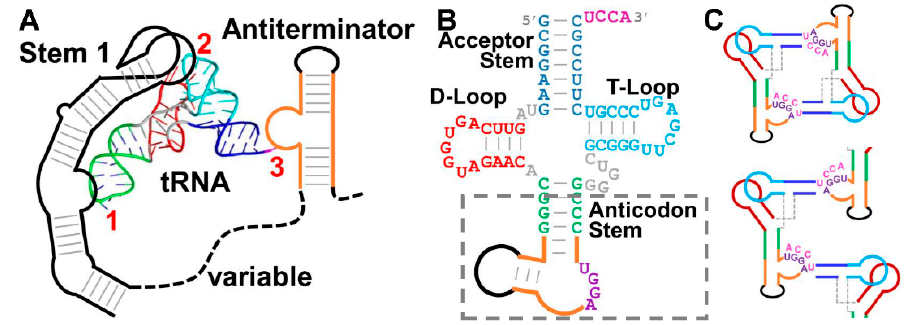
Figure 1. Engineering tRNA fusions. ( A ) Schematic of the T-box riboswitch–tRNA complex with the three previously demonstrated intermolecular contacts highlighted by red numbers. The conserved T-box structure is shown schematically with stems indicated by grey base pairs and loops and bulges shown unpaired. The antiterminator portion of the T-box RNA that is the focus of this work is highlighted in orange. The more variable region of the T-box structure is indicated by a dashed line. tRNA is shown as a cartoon with the acceptor stem in blue, the D-loop in red, the anticodon stem loop in green, the T-loop in cyan and the 3 ′ acceptor extension in magenta. ( B ) Secondary structure model of the G. kaustophilus tRNA Gly scaffold used in this work, colored as in Panel A, with antiterminator stem-loop insertions (highlighted by a dashed grey box) in the anticodon stem represented by orange lines. The UGGA motif (purple) in the antiterminator single-stranded bulge is the tRNA acceptor (UCCA) binding site from the T-box riboswitch antiterminator. ( C ) Potential intermolecular complexes hypothesized, either dimeric (top) or bridging (bottom) during engineering of the tRNA–antiterminator fusion. tRNA molecules are shown schematically and colored as in Panel B.